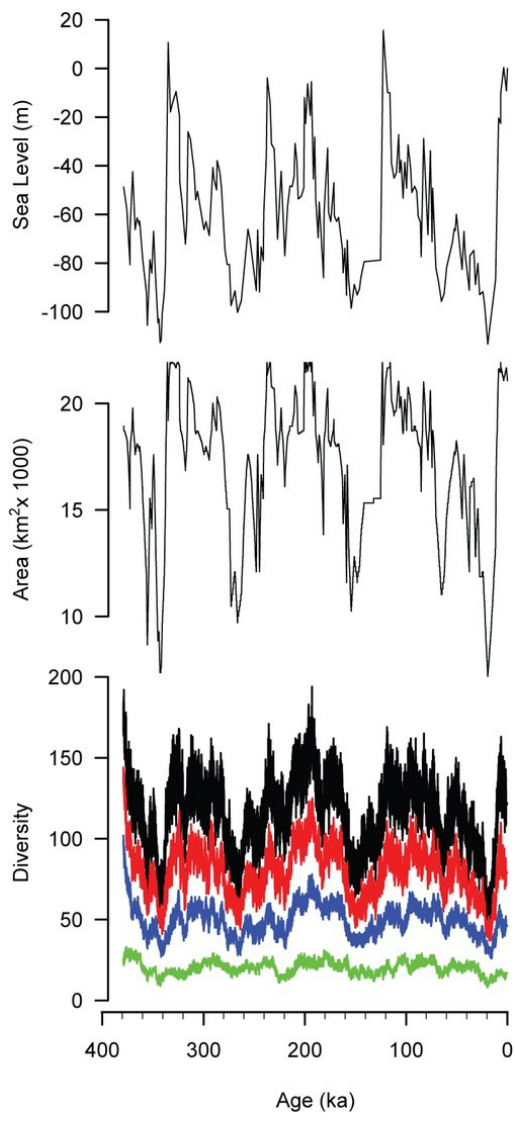
Figure 9. Sea level [25] for the past 379 kyr, with the area and modeled diversity of the Californian Province. The black diversity curve represents all species, red represents species with at least 10 individuals, blue is those with at least 100 individuals, and green is those with at least 1000